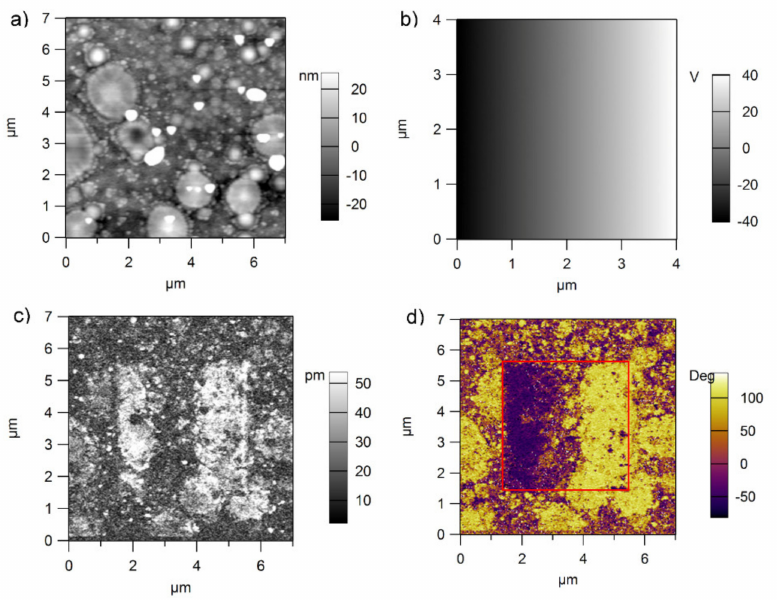
Figure 7. Topography ( a ), poling map ( b ) amplitude ( c ) and phase ( d ) of the PFM signal obtained after poling in the case of the PZT films deposited by sol-gel on an Si substrate with a bottom Pt electrode. The RMS was estimated to about 15